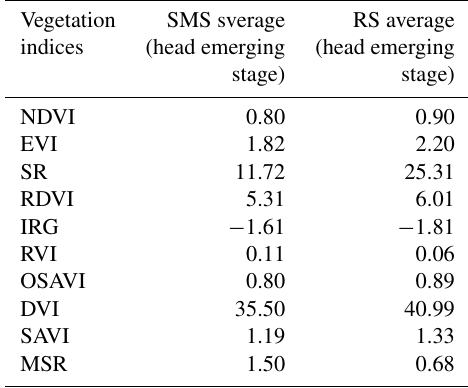
Figure 11. Same as Fig. 5, but for DVI.